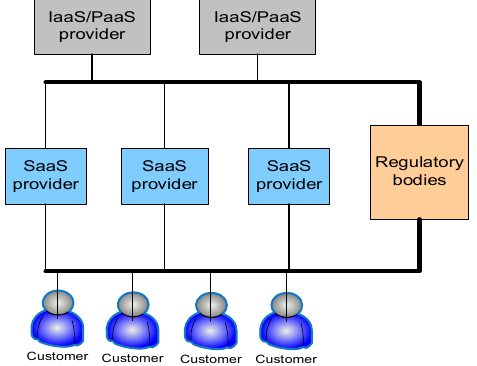
Figure 1. Three-tiered cloud service market.